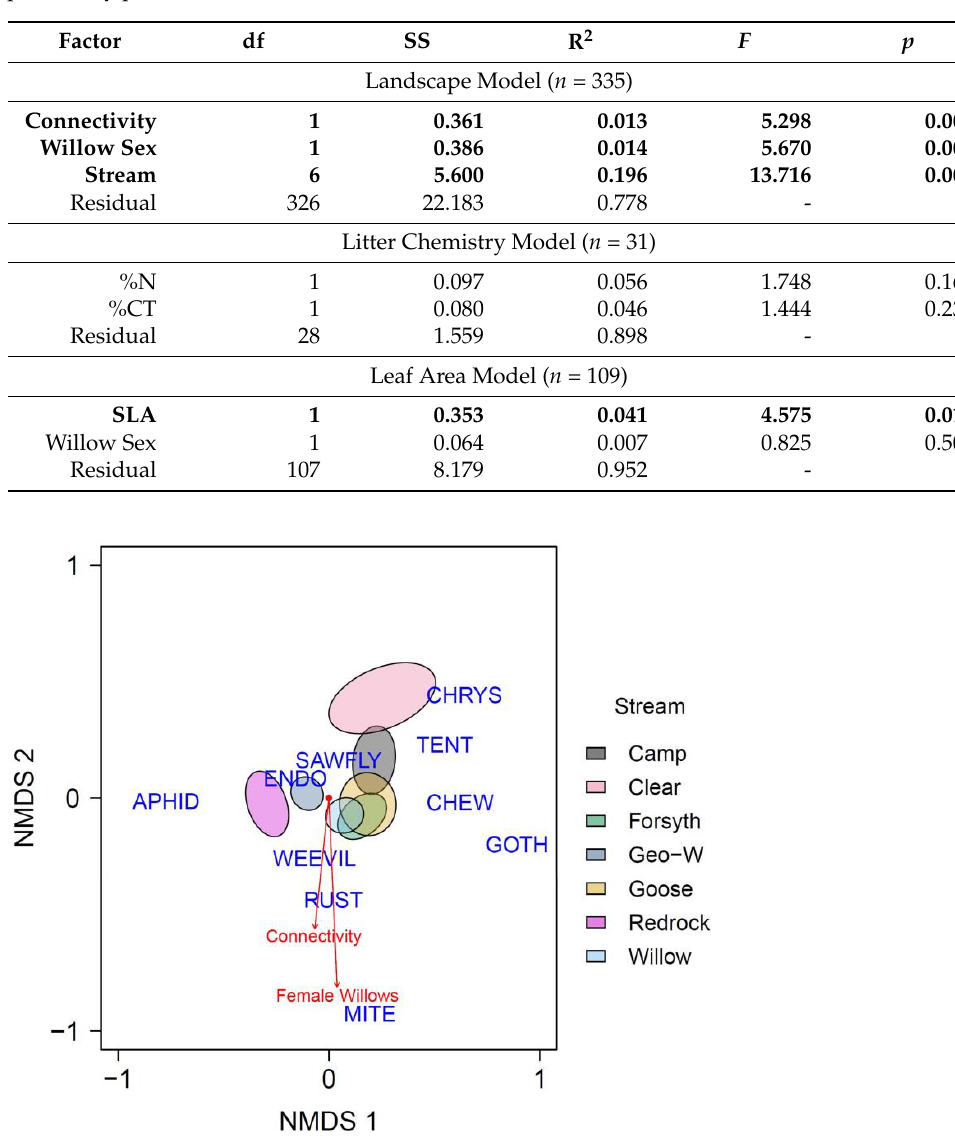
Figure 3. NMDS analysis (four-dimensional) examining dependent-community dissimilarity on tagged willow shrubs for our landscape-level parameters. Points omitted to focus on community member differences versus parameters of assembly. Blue words are centroids for the 10 observed community members. Stream ellipses are 95% confidence intervals. The relative length of connectivity and female willow vectors indicate the strength of the effect of that parameter on related community members. To find the best NMDS outputs, we sequentially increased the number of dimensions until stress was reduced to <0.1, based on 999 iterations and 200 random starts. Abbreviations: CHEW represents unidentified chewing guild arthropods, CHRYS represents chrysomelid beetles, ENDO represents endosymbiont organisms on willows, GOTH represents unidentified caterpillars, RUST represents fungi creating leaf rust on willow leaves, and TENT represents tent caterpillars.